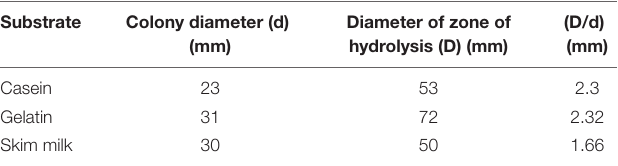
TABLE 3 | Qualitative screening of proteolytic isolate MP 27 on different proteinaceous substrates. Substrate Colony diameter (d) Diameter of zone of (mm) hydrolysis (D) (mm)